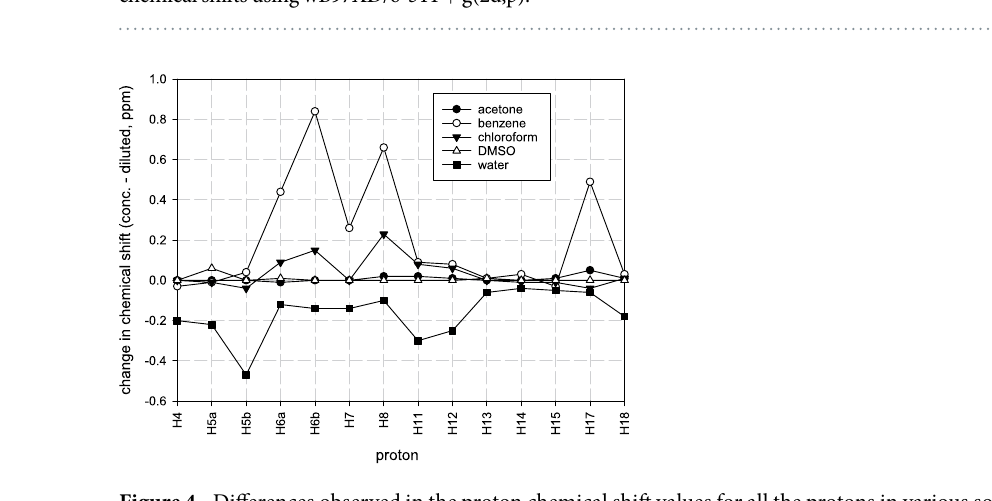
Figure 4. Differences observed in the proton chemical shift values for all the protons in various solvents of colchicine